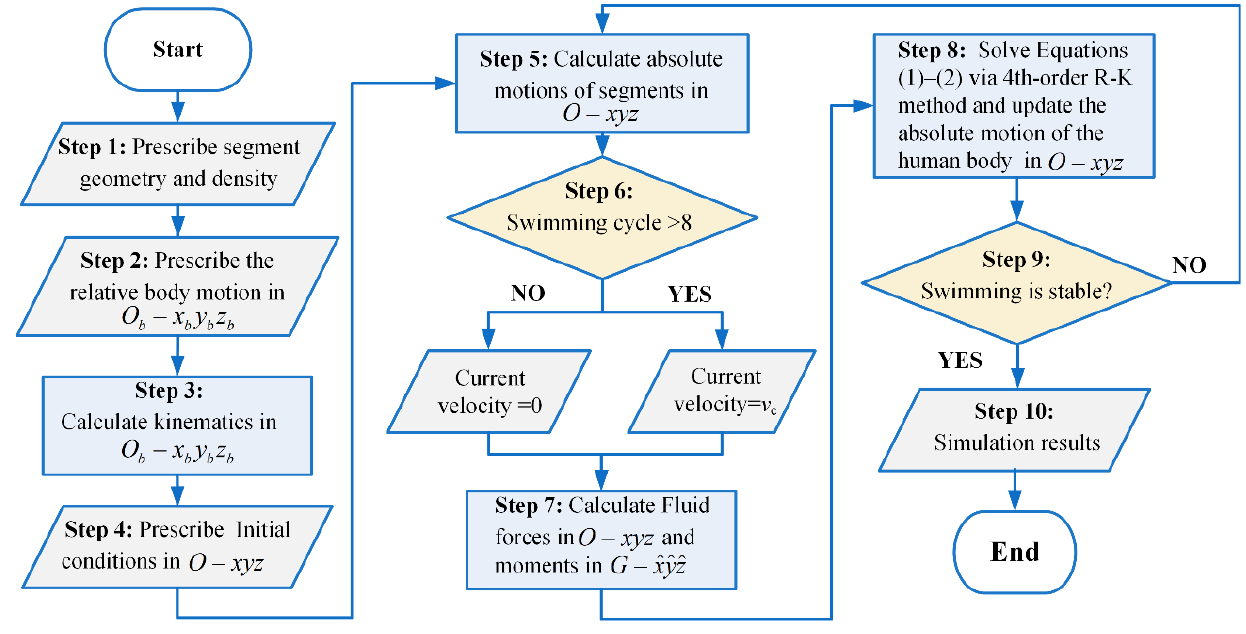
Figure A1. The calculation process.